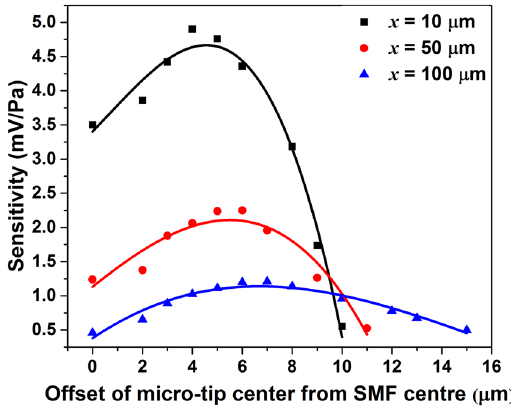
Figure 4. The experimental sensitivity variation with different offset values at different distances of micro-tip from SMF end ( x